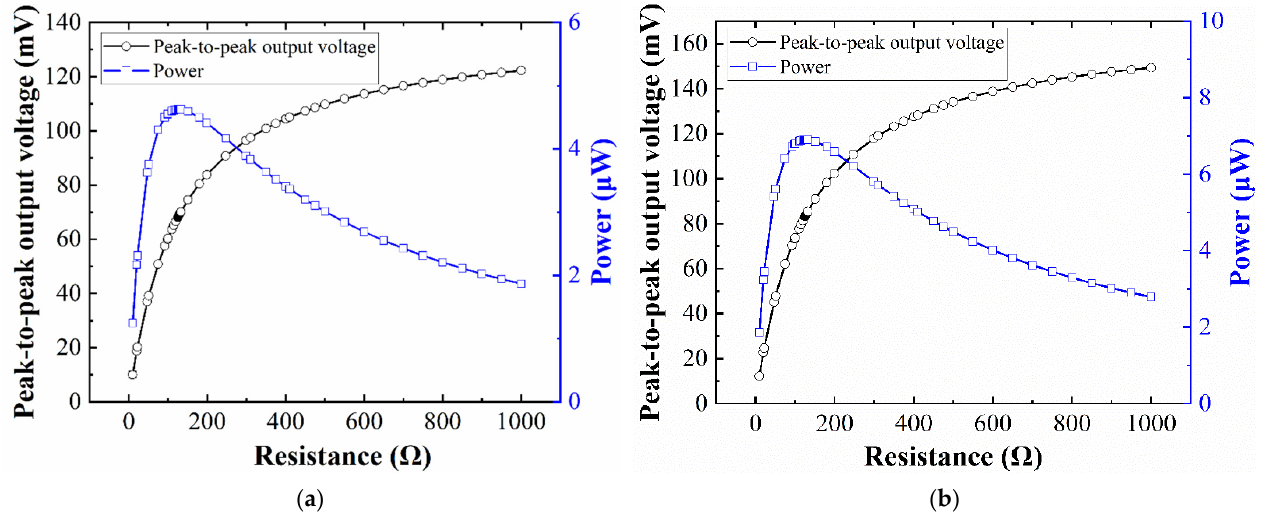
Figure 9. The peak-to-peak output voltage and power of the EVEH as a function of load resistance: ( a ) T1 device; ( b ) T2 device.